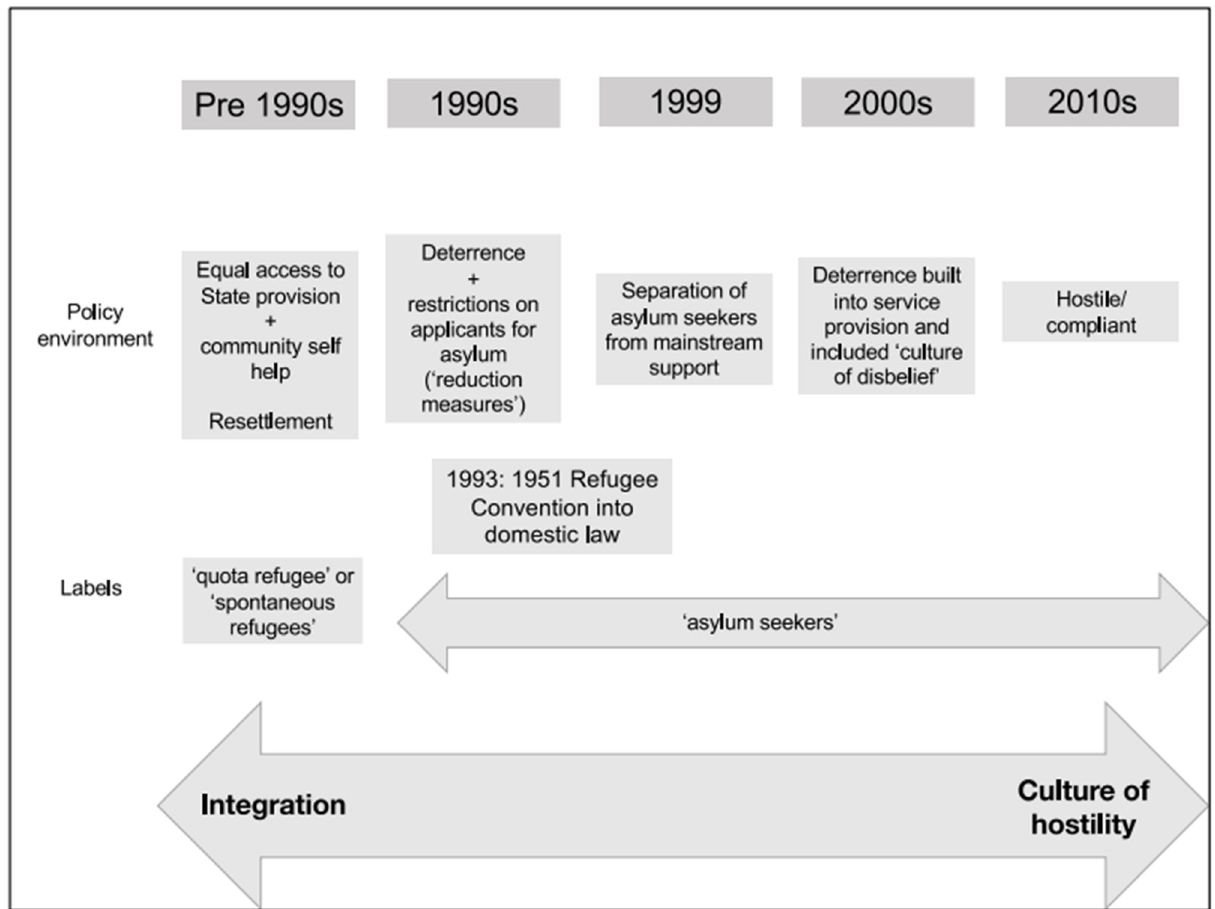
Figure 3. UK policy environment and labels for people fleeing persecution over time.